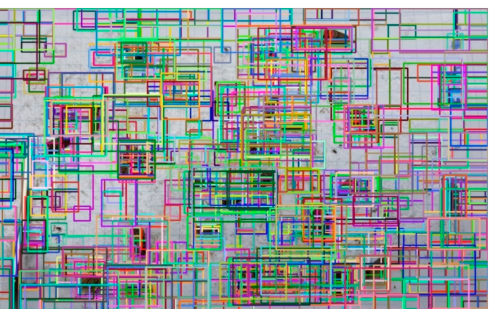
Figure 6. All proposals of the selective search method. Proposals are visualized in random colors.